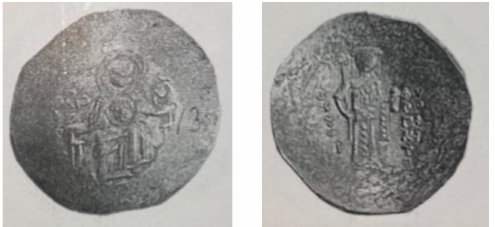
Figure 9. First Indiction Aspron Trachy Nomisma, 1118–1122; impression on billon; Dumbarton Oaks, Washington D.C.; B.11.1 Bertel è 1956 (H. Pl. 11.3). Published at [15] ( DOC , pp. 224, 226, 228, 231, 234, images on Plates VIII and IX), [37].